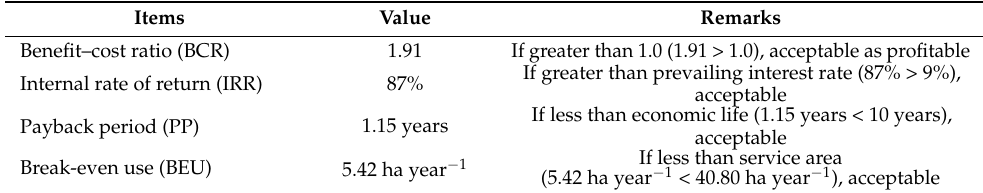
Table 9. Project worth evaluation of medium combine.